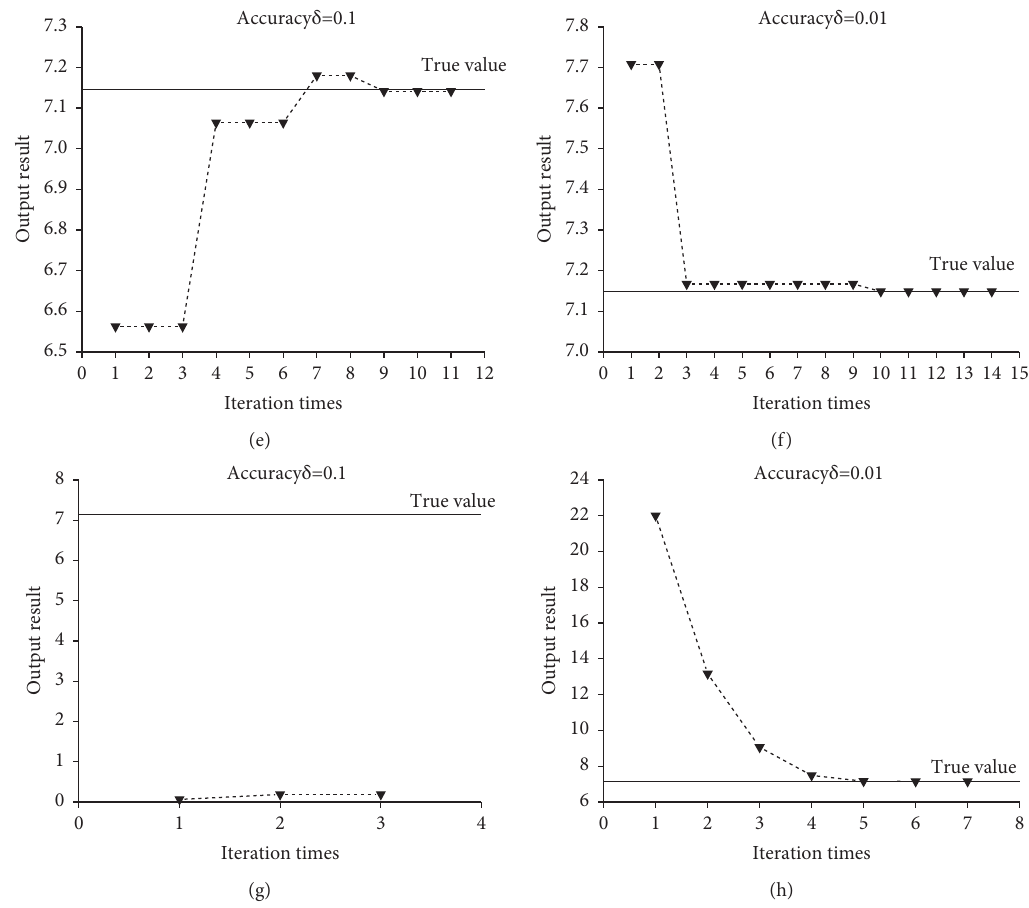
Figure 2: The relationship between the number of iterations of various algorithms and the true value. (a) New algorithm iteration results at an accuracy of 0.1. (b) New algorithm iteration results at an accuracy of 0.01. (c) Golden Section method results at an accuracy of 0.1. (d) Golden Section method results at an accuracy of 0.01. (e) Fibonacci method results at an accuracy of 0.1. (f) Fibonacci method results at an accuracy of 0.01. (g) Newton method results at an accuracy of 0.1. (h) Newton method results at an accuracy of